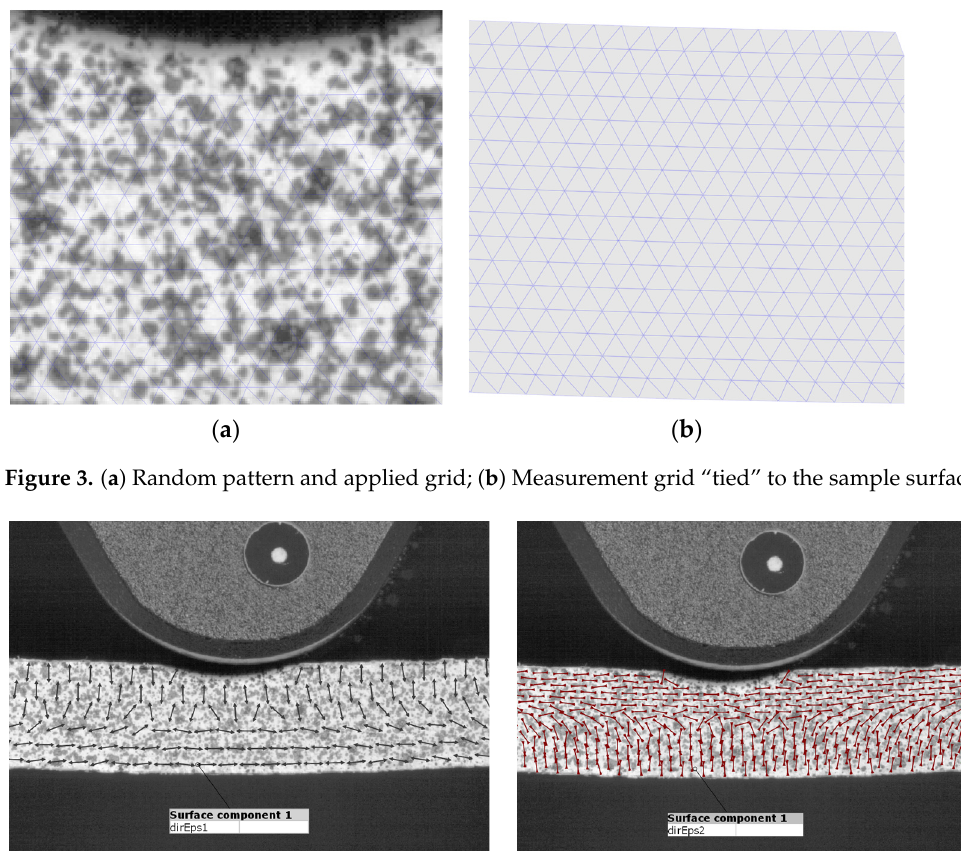
Figure 3. ( a ) Random pattern and applied grid; ( b ) Measurement grid "tied" to the sample surface 166